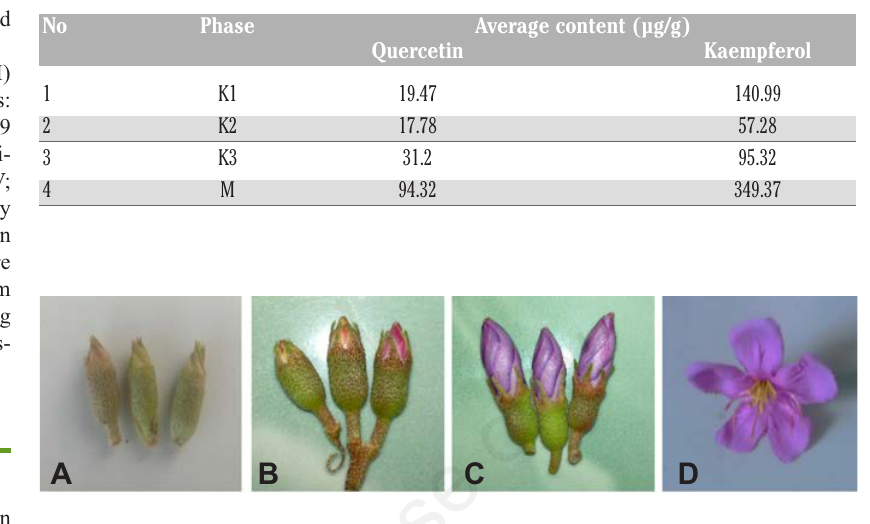
Table 1. Average levels of quercetin and kaempferol in various phases of flowering and fruiting.